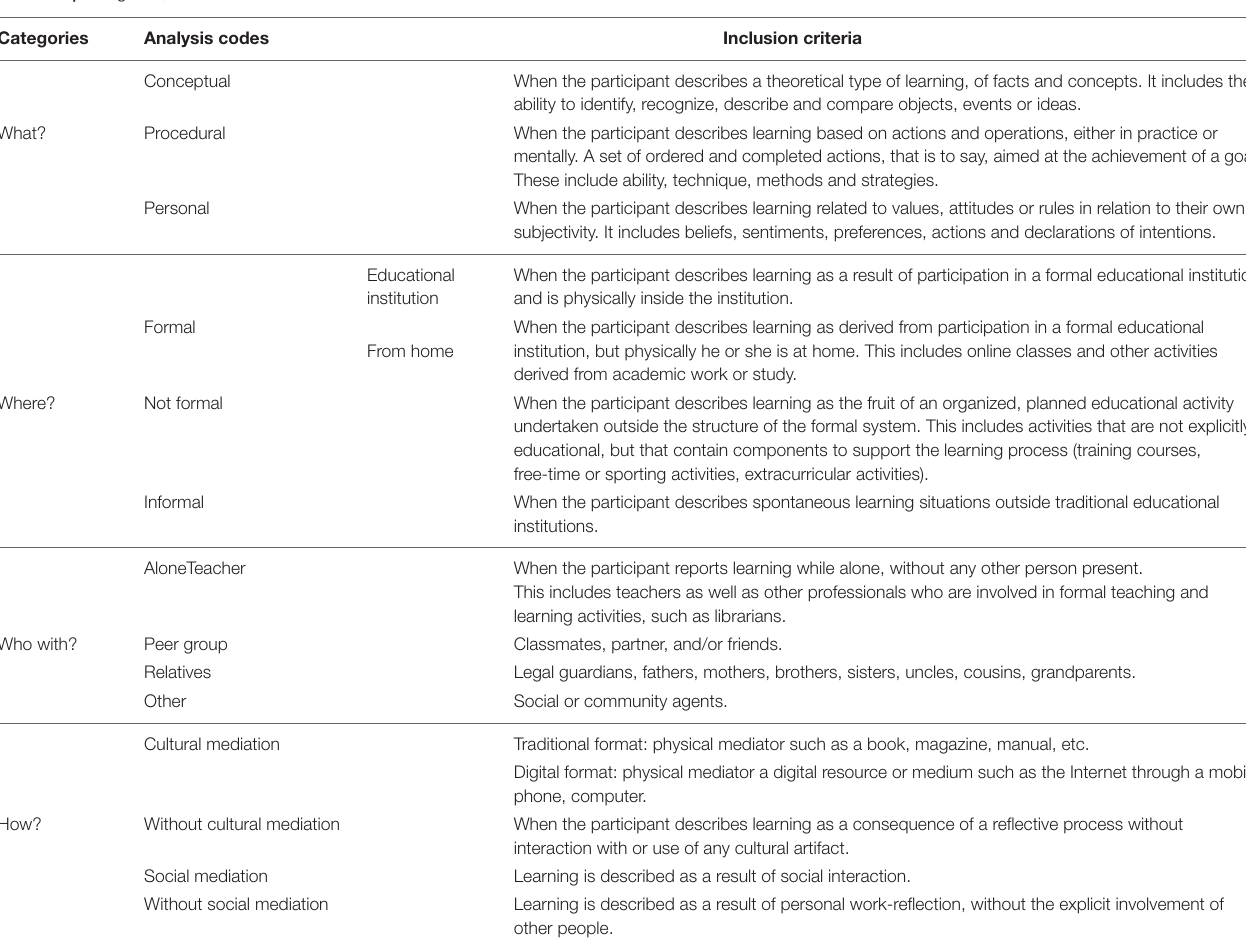
TABLE 3 | Categories, codes and inclusion criteria